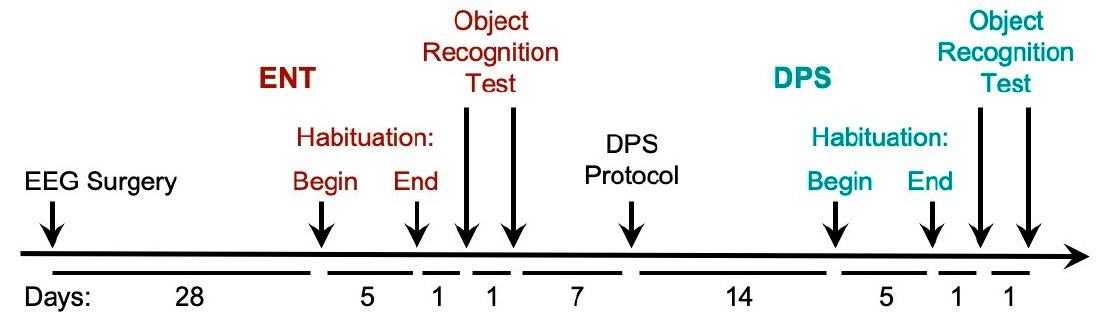
Figure 1. Timeline of procedures for experiment 1. Male hamsters were 2–3 months old at the time of the EEG surgery. Animals in the circadian-intact entrained (ENT, red) condition were then made circadian-arrhythmic by the disruptive phase shift (DPS, green) protocol and re-tested. The amount of time between each procedure is given in days below (timeline not to scale). Brain surgery for SCN-lesioned and Sham-operated animals was performed 4 weeks prior to the EEG surgery. Age-matched hamsters used for video tracking did not undergo surgery. For all animals, the object recognition test was conducted during the last 2 h of the day. The test consisted of 20 min of baseline EEG recording followed by 5 min of object exploration. See text for details of all procedures.